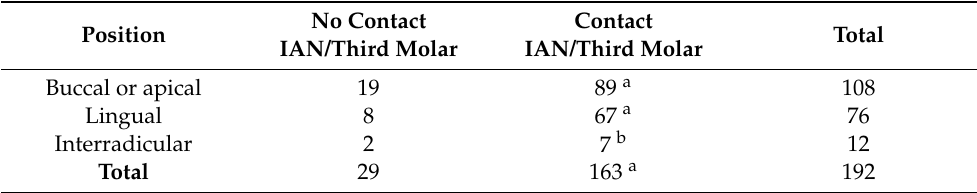
Table 4. Distribution of the elements regarding direct contact with the mandibular canal *. No Contact Contact Total Position IAN/Third Molar IAN/Third Molar Buccal or apical 19 89 a 108 Lingual 76 Interradicular 2 Total 29 163 a